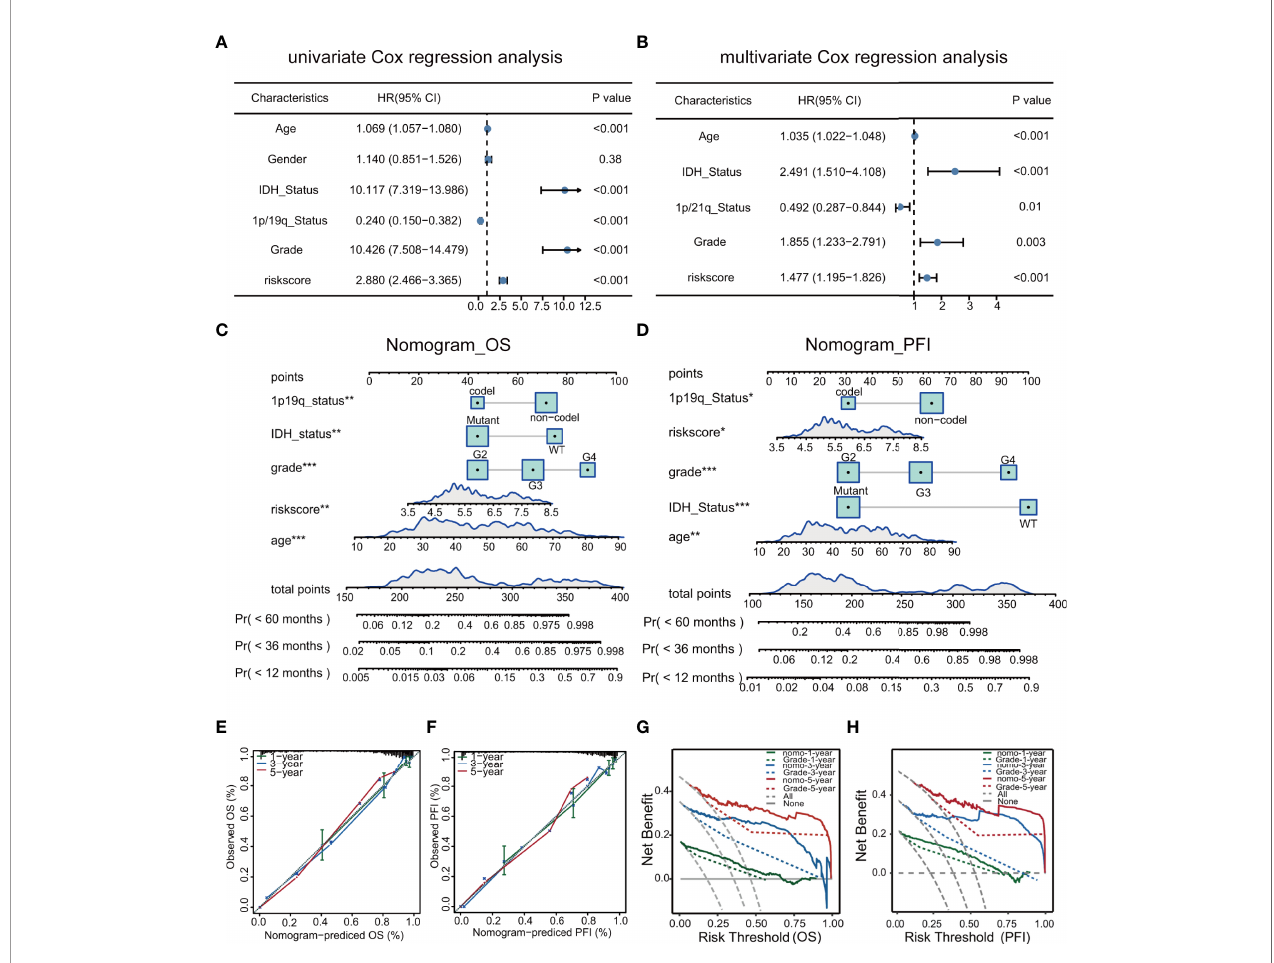
FIGURE 7 | Univariate and multivariate analyses of clinical features in relation to prognosis (A, B) . Nomograms for prediction of OS and PFI (C, D) . Nomogram calibration using OS and PFI for predicted and actual one- three-, and fi ve-year outcomes (E, F) . DCA of nomograms for OS and PFI for one- three-, and fi ve-year survival (G, H)